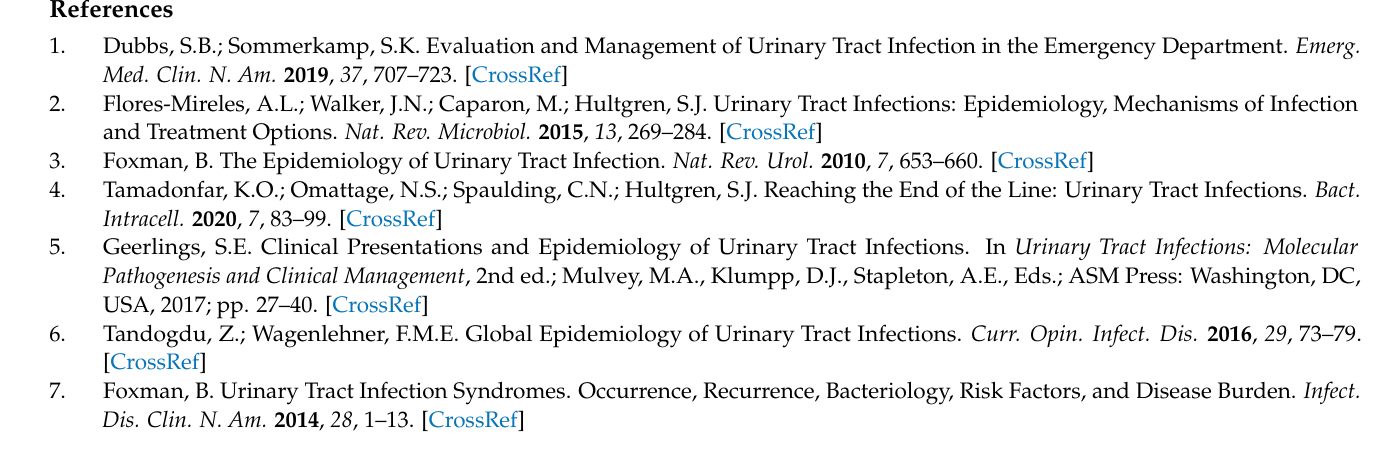
Table S4: Frequency of phylogroups and molecular classification markers regarding occurrence of UTI